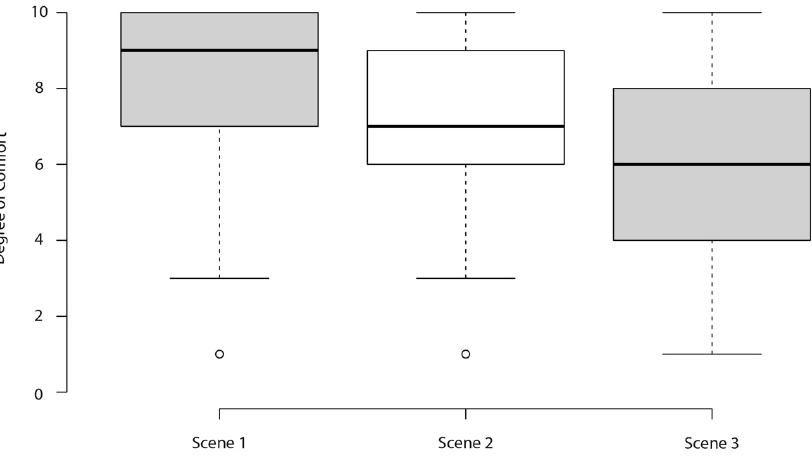
Figure 8. Reports of participants’ level of comfort in each of the scenarios. Scene 1: null alcohol exposure; Scene 2: medium alcohol exposure; Scene 3: high alcohol exposure. p -value assessed with Kruskal – Wallis.